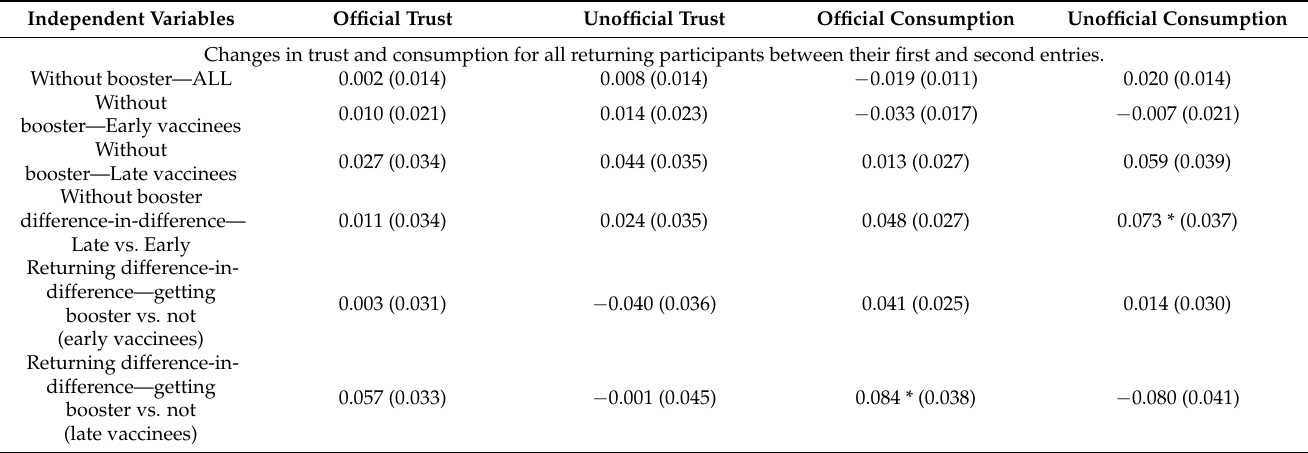
Table A5. Robustness check (parallel trends): Regression results outlying the longitudinal changes of all returning participants on trust in and consumption of official and unofficial information sources between their first and second entries. The rows focus on all returning participants, returning early vaccinees, returning late vaccinees, and the differences between early and late vaccinees, respectively. These results are based on OLS regressions controlled for individual fixed effects, and the coefficients are directly interpretable as unit percentage